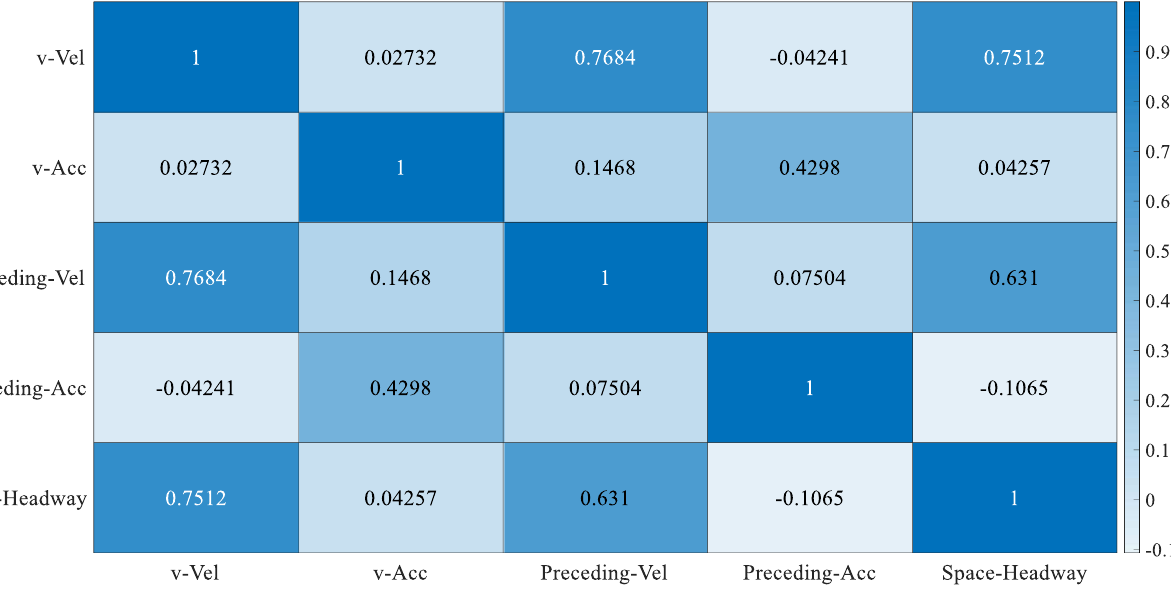
Figure 5. Spearman coefficient analysis results. By observing the Kendall correlation coefficient analysis results and Spearman correlation coefficient analysis results, it can be seen that the v_Vel variable has a large correlation with Space_Headway and Preceding_Vel, and it can be preliminarily concluded that: (1) v_Vel, as expected by the driver, is greatly affected by the Space_Headway and the Preceding_Vel, and it is found from the data changes that the greater the Space_Headway, the greater the expected v_Vel, and the greater the Preceding_Vel, the greater the expected v_Vel.